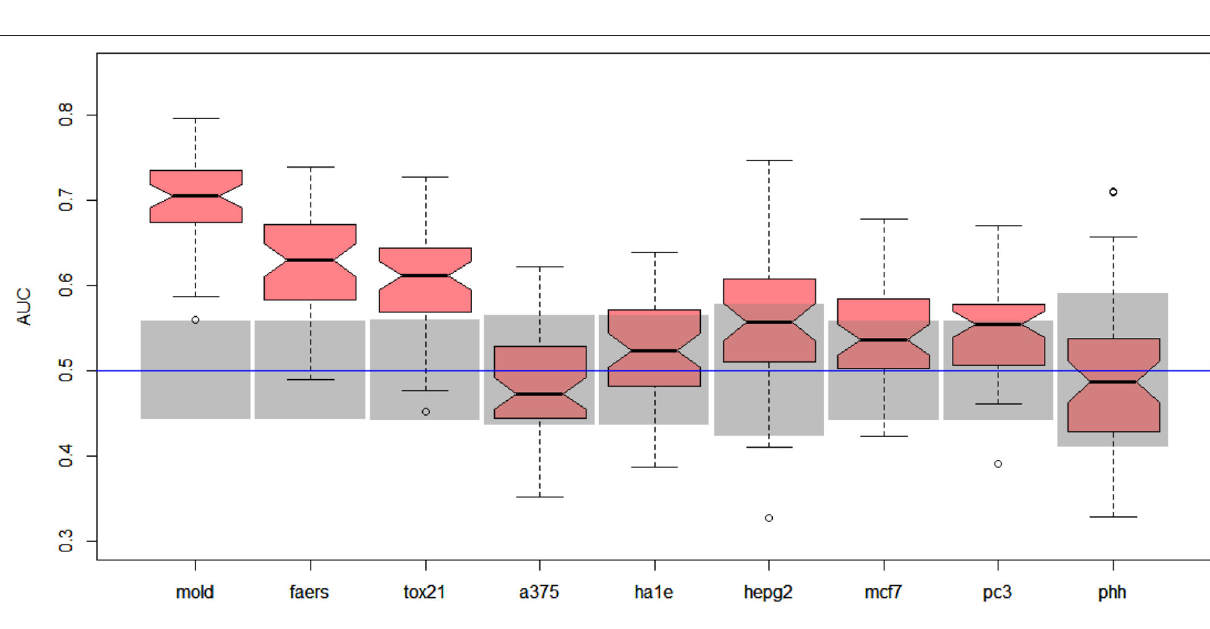
predictive models were obtained for HEPG2 lines for two binary divisions, and for and MCF7 for discerning between harmless compounds against all other